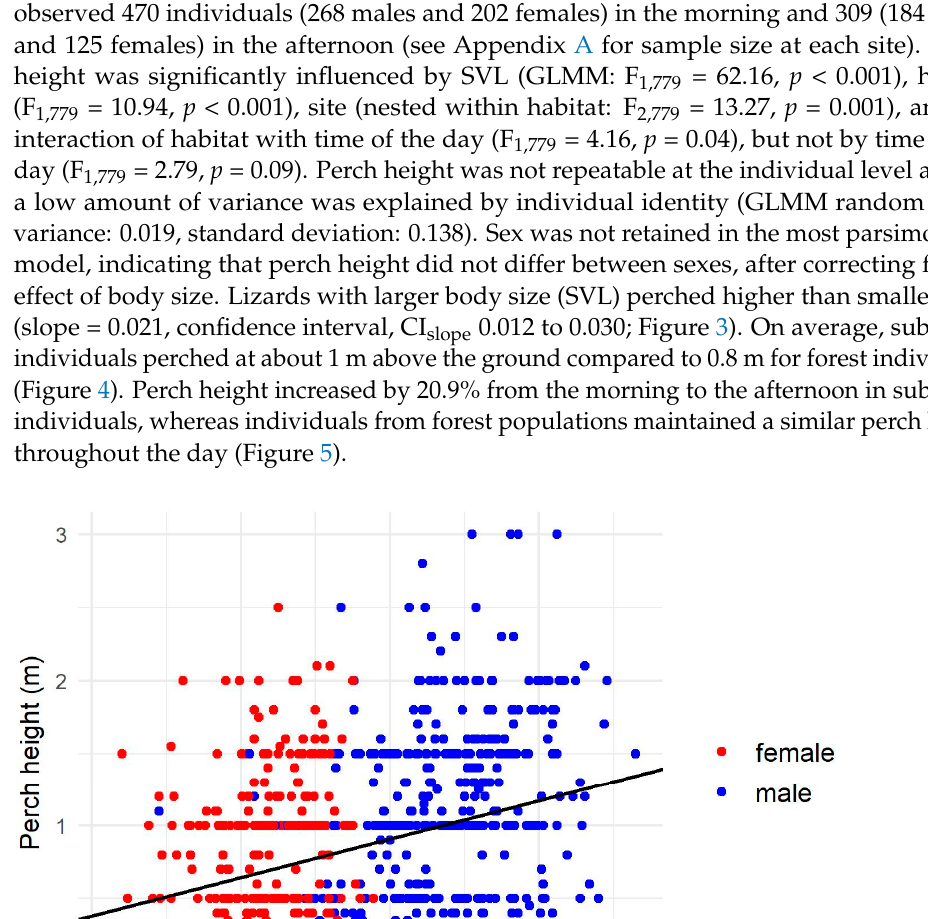
Figure 4. Perch height in suburban (black) and forest (green) populations of Anolis homolechis . Sam- pled sites are referred to as Site 1: Guanajay, Site 2: San José de Las Lajas, Site 3: Sierra del Rosario, and Site 4: Escaleras de Jaruco. Vertical bars indicate 95% confidence intervals.